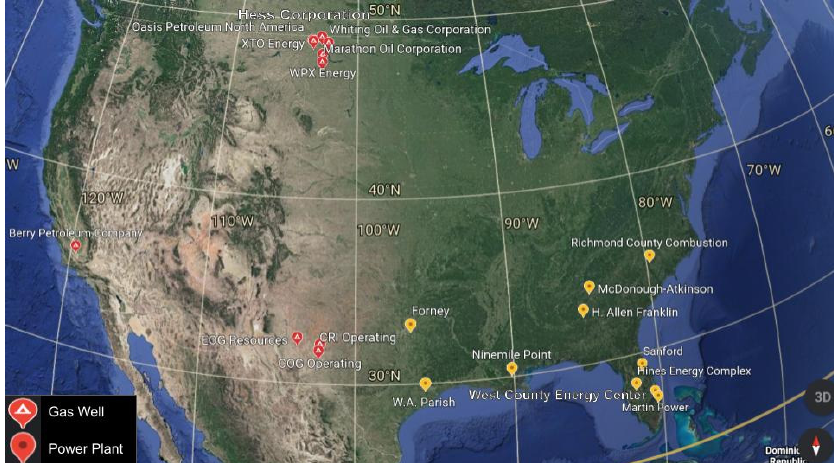
Figure 18. Map of Top 20 CO 2 Emission Bottlenecks- Natural Gas Extraction Facilities & Power Plants in the United States (Generating using Google Earth).